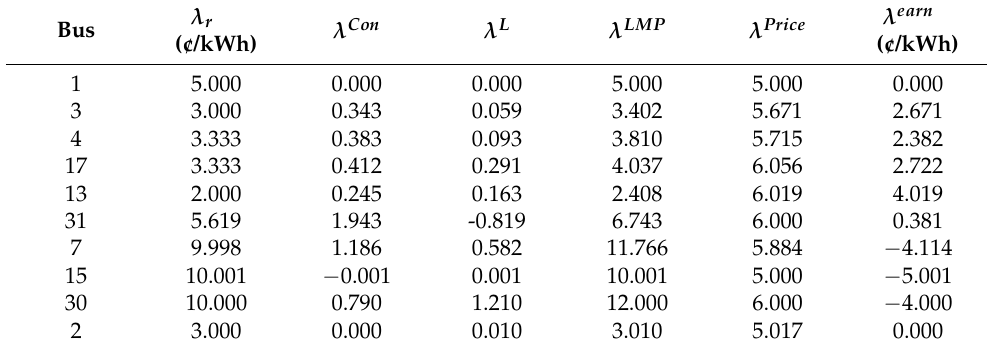
Table 5. Nodal Marginal